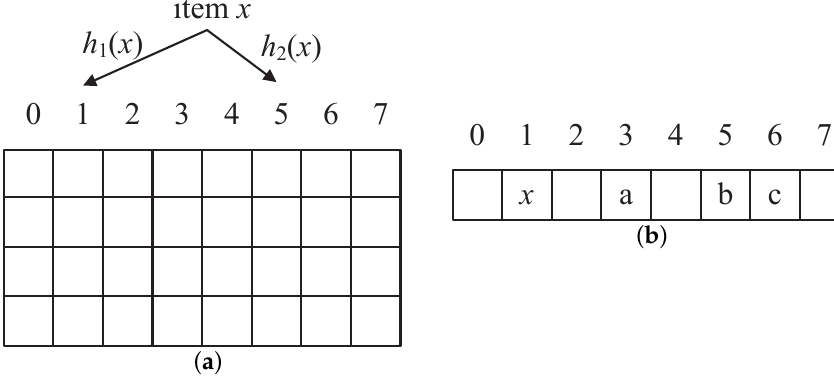
Figure 2. Cuckoo hashing table. ( a ) the basic cuckoo hashing table; ( b ) inserting a new